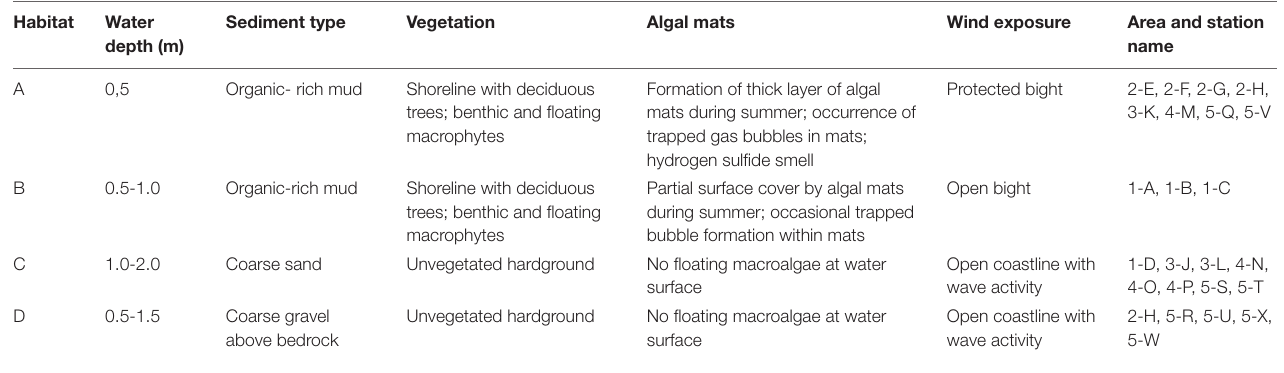
TABLE 1 | Habitat with corresponding sampling stations in the respective habitats and sampling